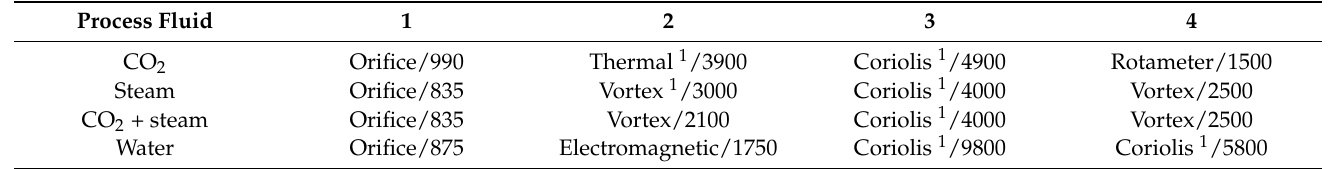
Table 8. Maximum errors of studied solutions at rated flow, %.